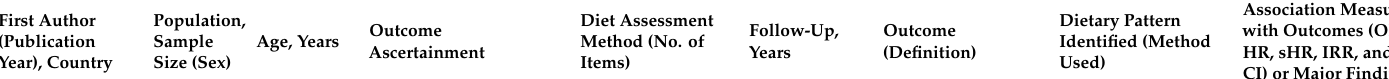
Table 1. Characteristics of the prospective studies of dietary patterns and renal